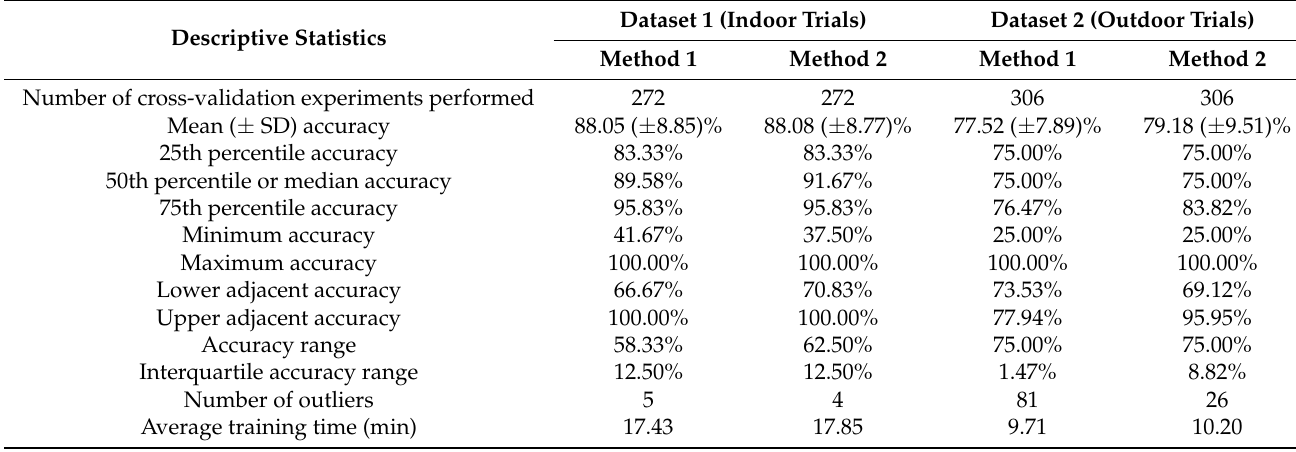
Table 5. Descriptive statistics of the classification accuracies obtained with the training, validation, and testing data and the two cross-validation methods with the two